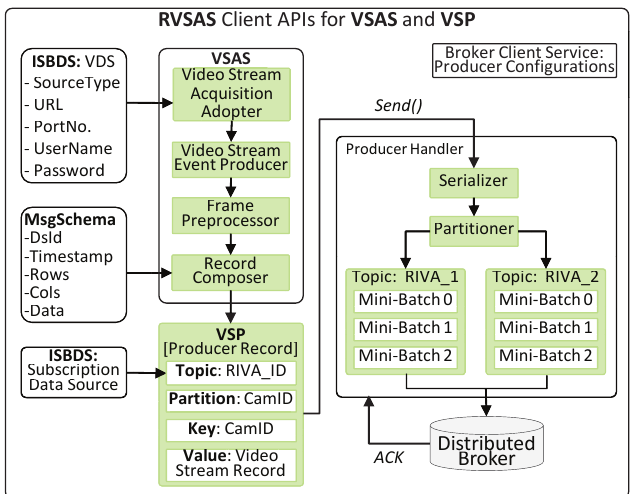
Figure 4. The internal logic and flow of the Video Stream Acquisition Service (VSAS) and Video Stream Producer